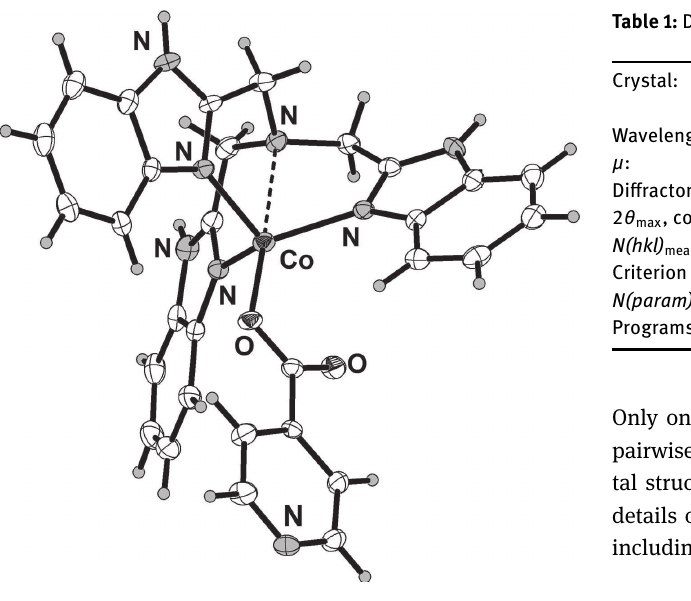
Table 2: Fractional atomic coordinates and isotropic or equivalent isotropic displacement parameters (Å 2